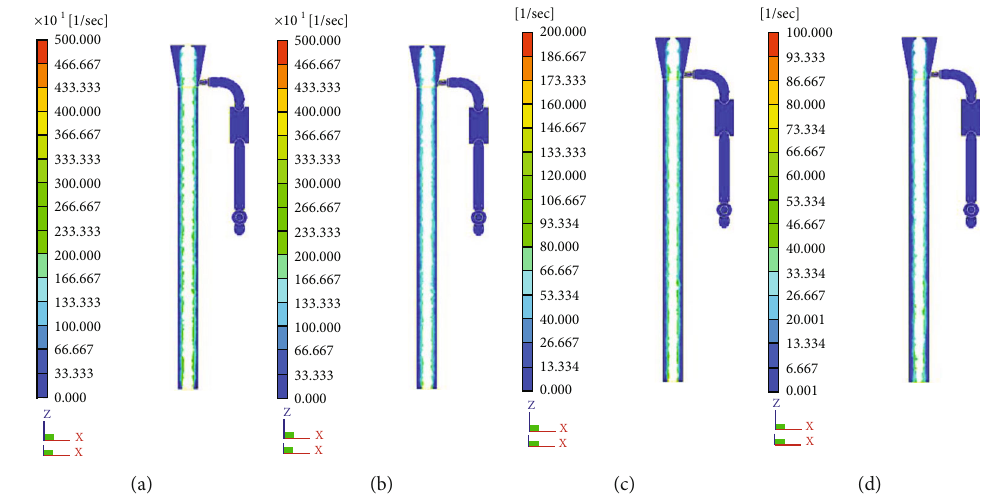
Figure 6: Shear rate distribution at di ff erent water injection delay